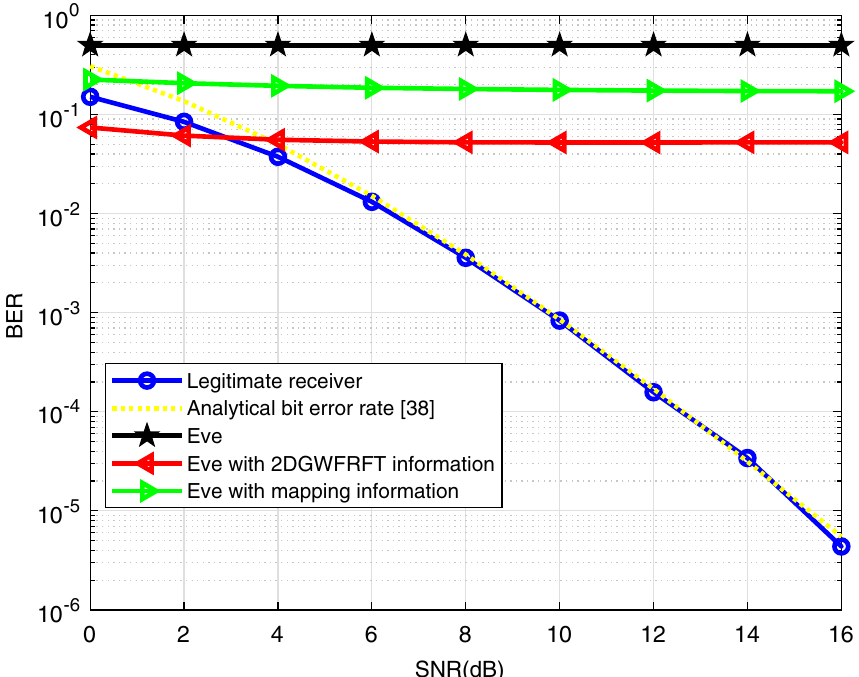
Fig. 9 BER performance of the proposed scheme with analytical result and